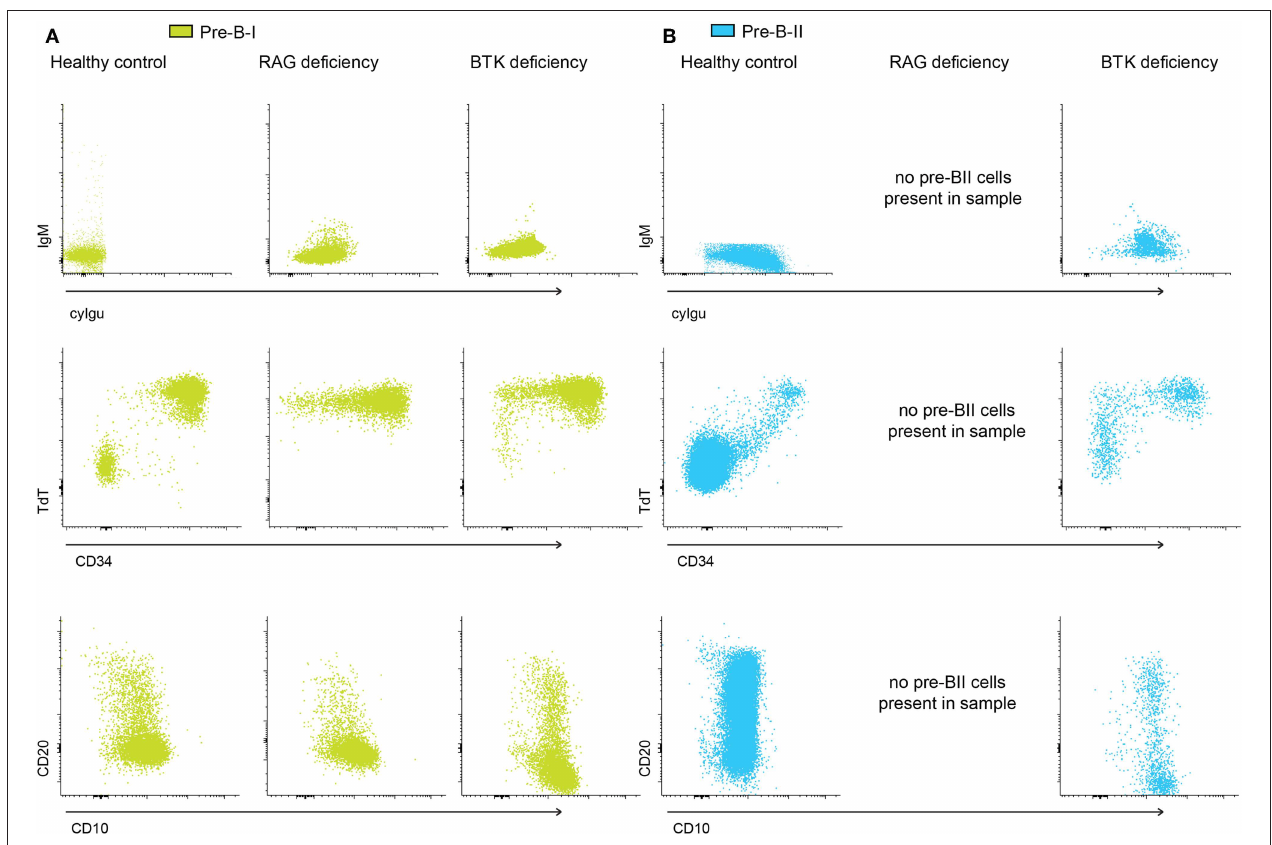
FIGURE 3 | pre-BI and pre-BII marker expression in control and patient samples. (A) Dot plots representing pre-BI cells from a control sample, and two patient samples, indicating the uncoupling of expression of cyIg µ and surface markers like CD34, CD20, and CD10. In both the control and the patients, cells without cyIg µ can lose CD34 expression and gain CD20 expression. (B) Dot plots representing pre-BII cells from a control sample, and two patient samples. In both the control and the patients, cells with cyIg µ expression can still express CD34 and TdT, and CD20 expression is